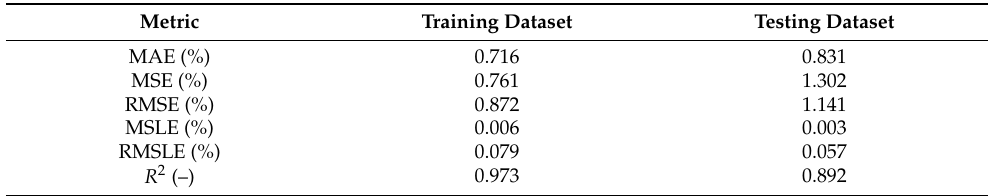
Figure 17. Correlation performance of the best SVM model to predict the damping ratio for ( a ) training and ( b ) testing datasets. Table 8. Overall performance of the best SVM model to predict the damping ratio for both training and testing datasets.